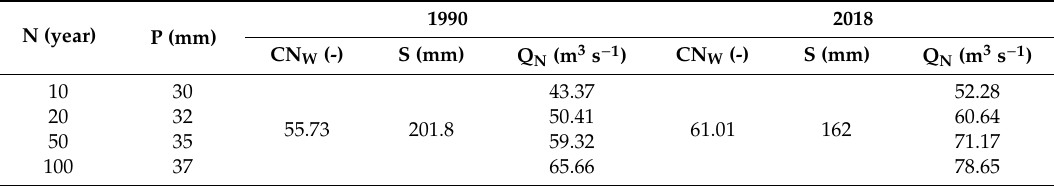
Table 11. Estimation of the design floods for the Ipoltica River basin using the actual design values of the short-term rainfall (N–return period; P–design values of short-term rainfall; CN w –weighted CN value; S–maximum potential retention; Q N –the design flood).